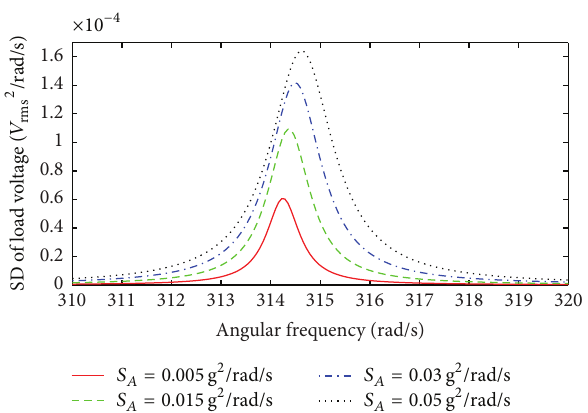
Figure 12: SD of the load voltage as a function of angular frequency for high levels of broad band Gaussian white noise random excita- tion; spring scaling factor 𝜂 = 5 m −2 and damping scaling factor 𝛼 = 0.05 s 2 m −2 .